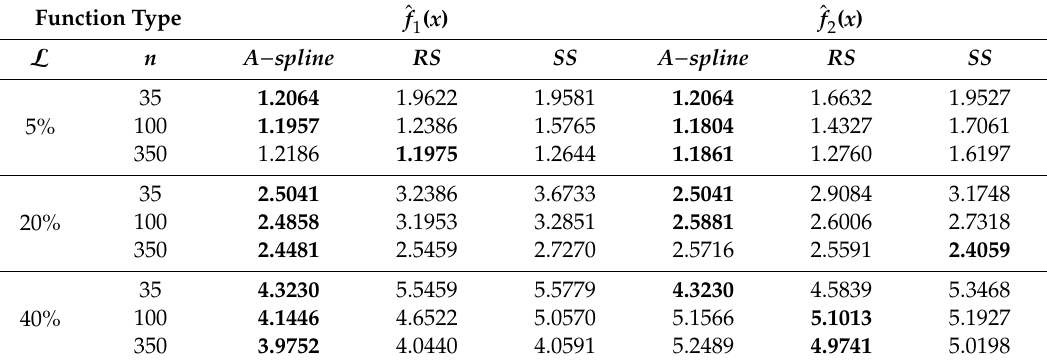
Table 3. MSE values for the A-spline, smoothing spline (SS), and regression spline (SS) methods to make